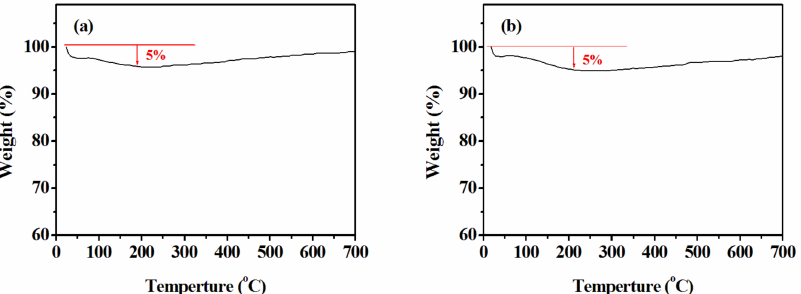
Figure 7. TG analysis of the formed WO 3 with different shapes. ( a ) WO 3 nanobundles, ( b ) WO 3 nanorods.